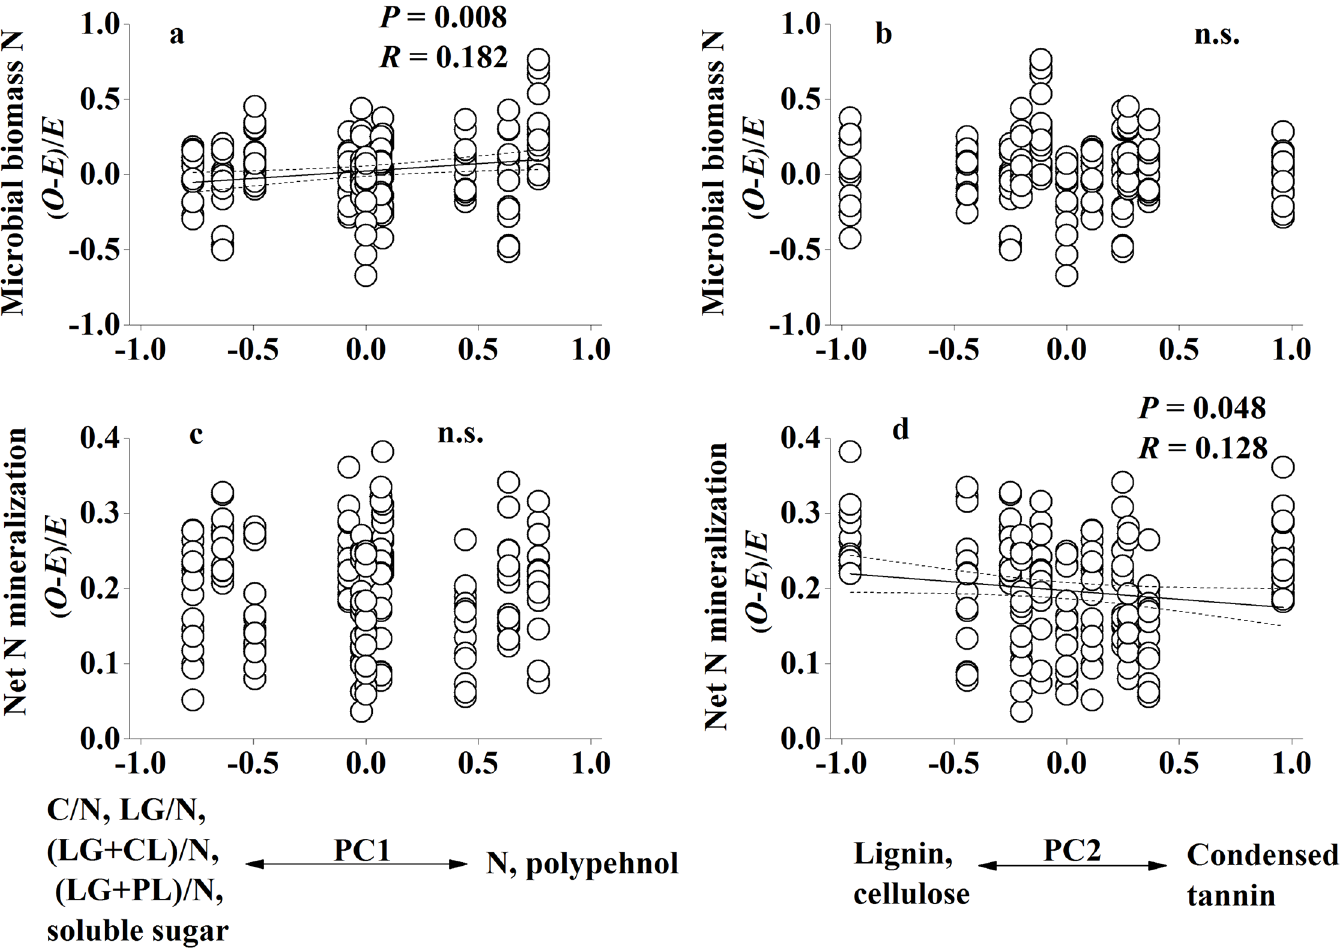
Fig 4. Non-additive soil microbial biomass N (a and b) and net N mineralization (c and d) response to litter mixtures as a function of the first and second PC axes, respectively, that were used to describe chemical composition of litter. Dashedlines represent the 95% confidenceinterval of the regression. O : observedvalues; E : expectedvalues. n.s.: not